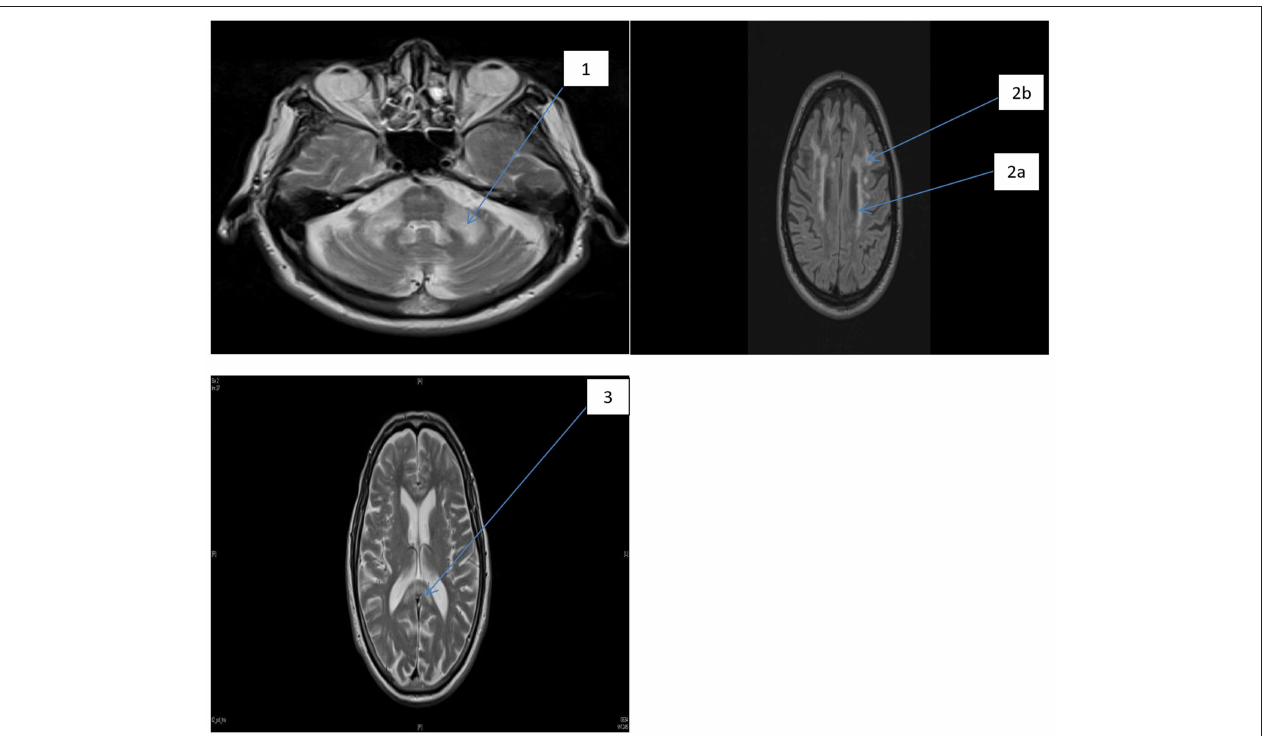
FIGURE 1 | FLAIR MRI axial section of two representative patients with FXTAS. MCP sign and foci of wmhs (1), the periventricular wmhs (2a), deep wmhs (2b), and wmhs in the splenium of the corpus callosum (3).